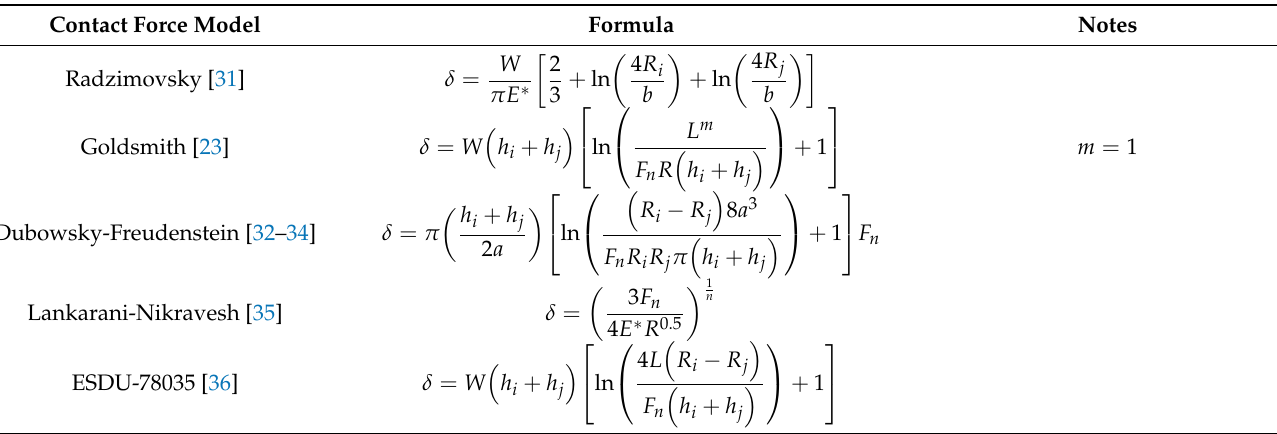
Table 1. Cylindrical contact-force